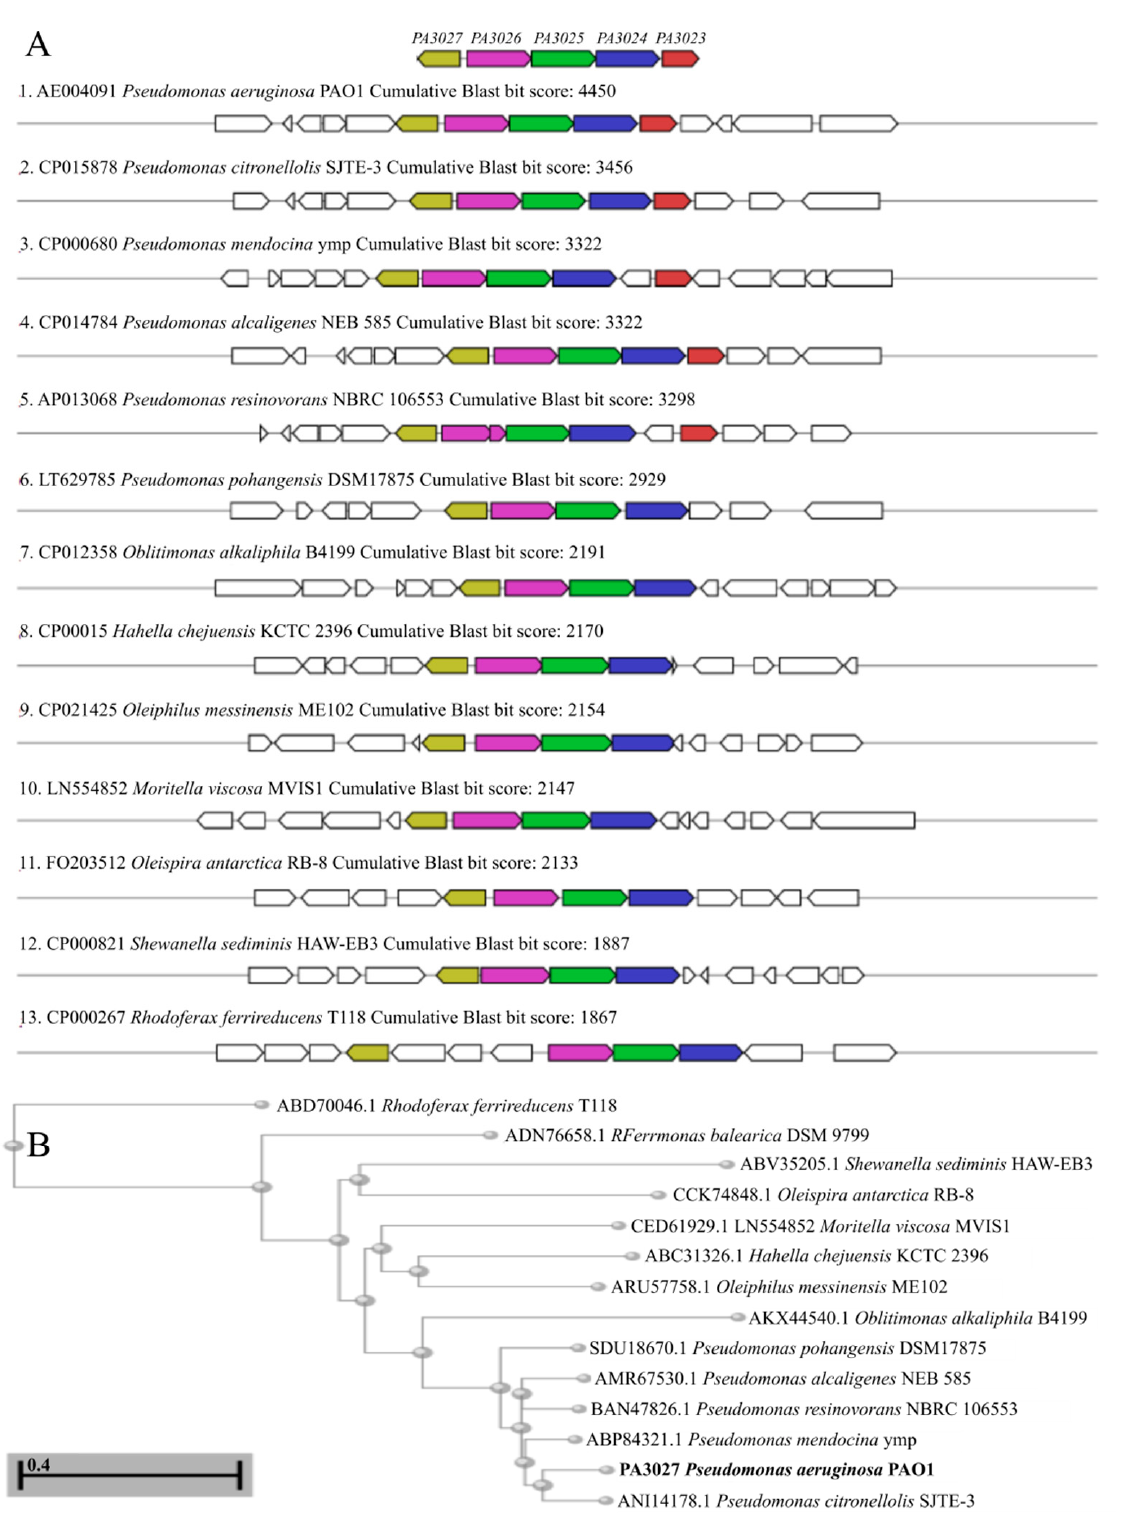
Figure A3. The occurrence of PA3023 – PA3027 gene cluster in bacteria. ( A ) Clustered genes encoding orthologs of PA3023 – PA3027 identified in 1748 representative and reference bacterial genomes included in the RefSeq database (release 91) [98] using MultigeneBlast [97]. ( B ) Phylogenetic tree of PA3027 and its identified orthologues, constructed using CoBaltDB [99].